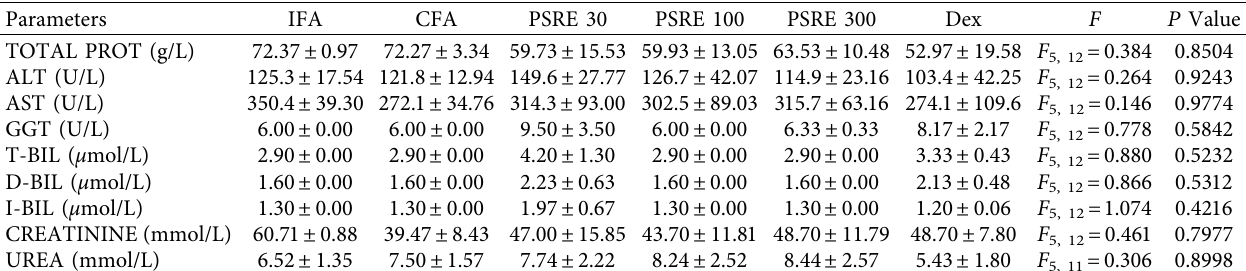
Table 2: Serum chemistry analysis of arthritic rats in the therapeutic